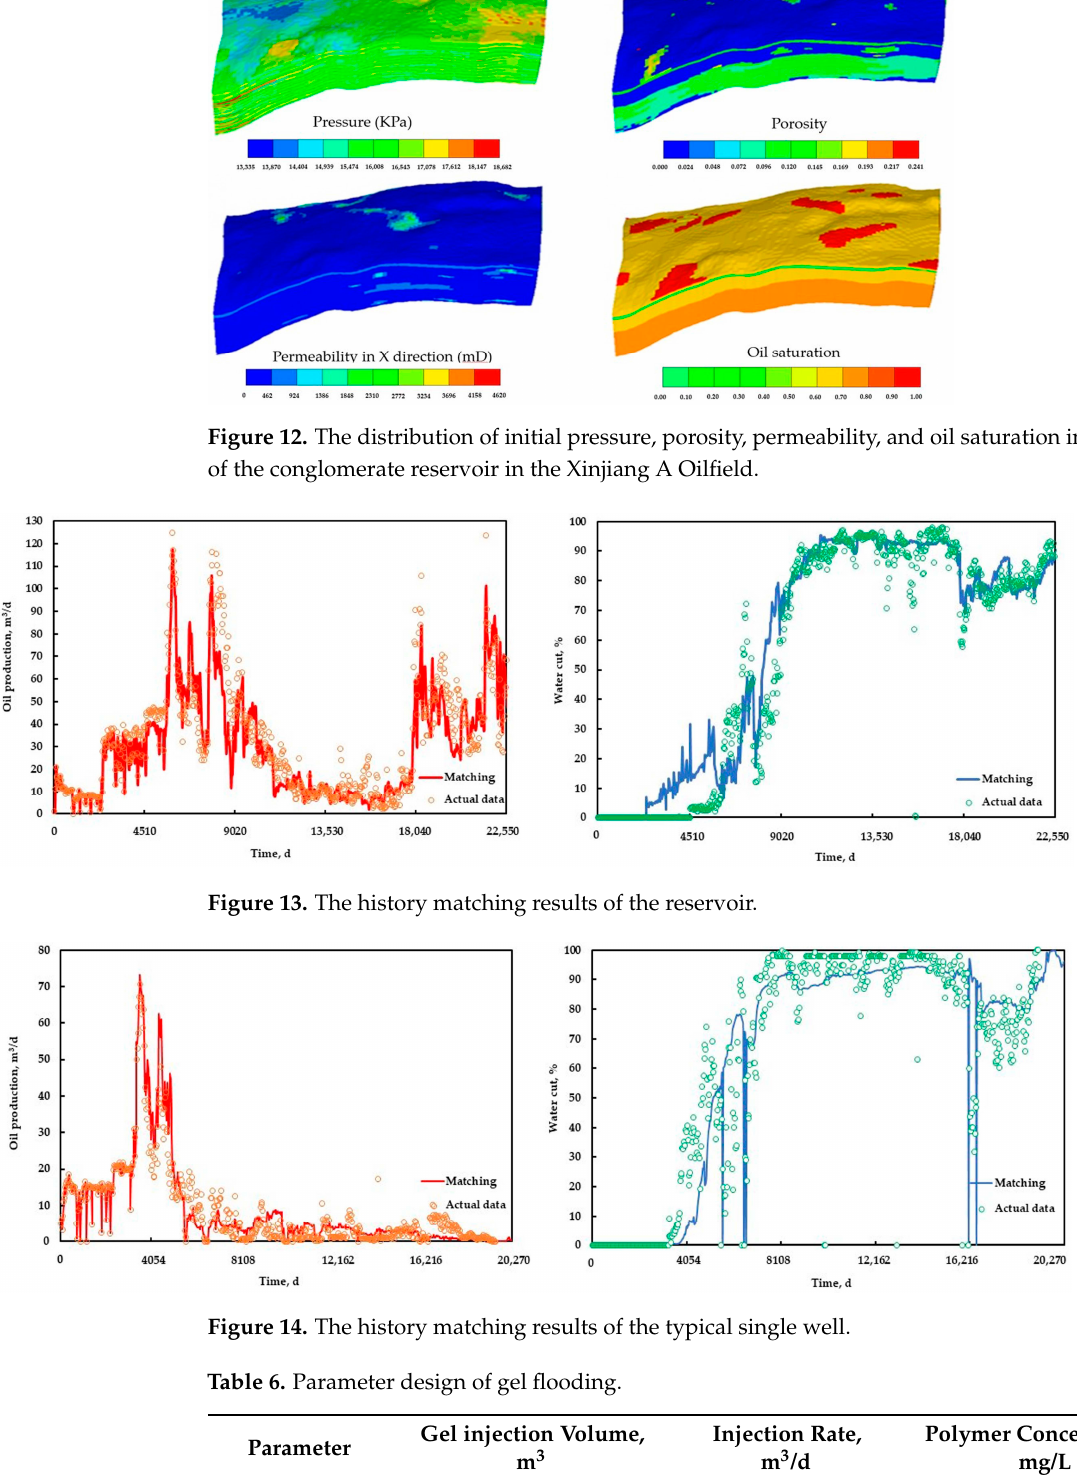
Figure 12. The distribution of initial pressure, porosity, permeability, and oil saturation in the model of the conglomerate reservoir in the Xinjiang A Oilfield.